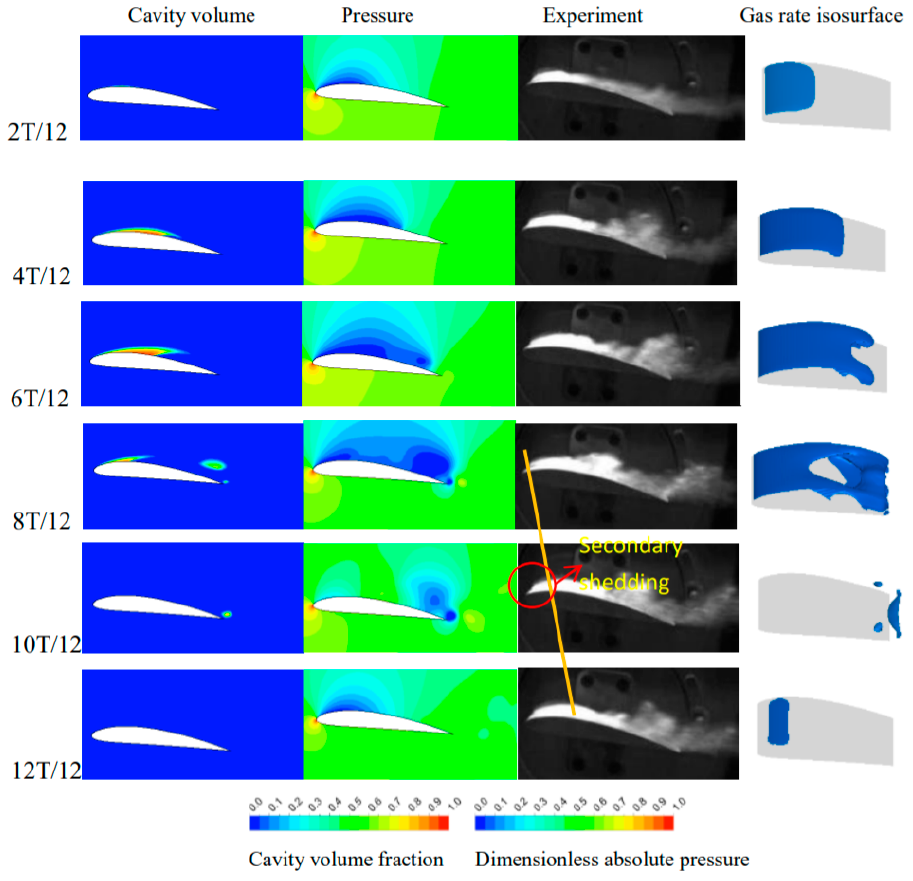
Figure 6. Flow field cloud diagram of 6° attack angle hydrofoil (gas rate isosurface α v = 0.1).